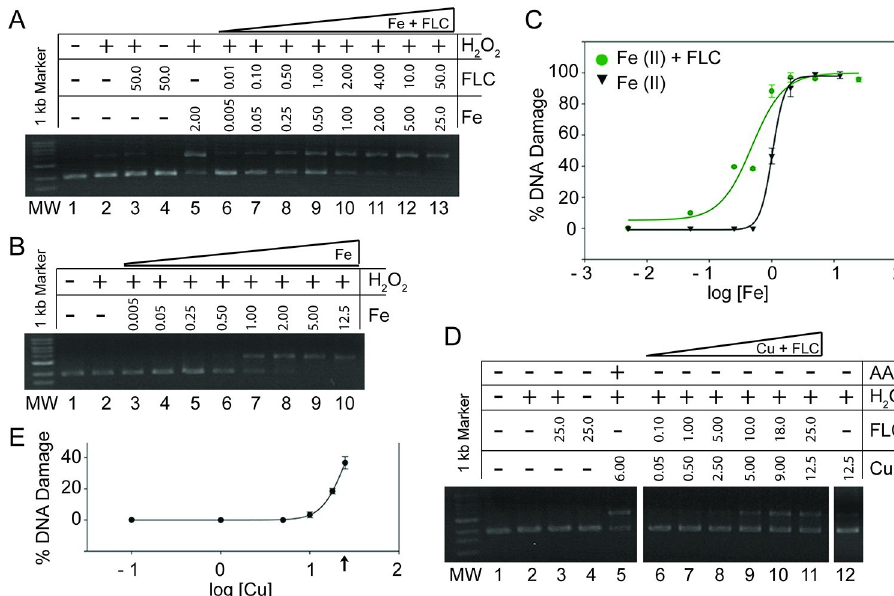
Fig 3. Fluconazole-metal complex causes DNA damage in vitro . A plasmid DNA (p) was incubated with reagents as indicated here and specified in the Materials and Methods. Samples were separated by electrophoresis, gels were stained with ethidium bromide and the amounts of nicked (damaged, upper band) and circular (undamaged, lower band) plasmid (p) were analyzed. In all gels shown (A, B and D), the MW: 1 kb molecular weight marker; lane 1: plasmid DNA (p); lane 2: p + H 2 O 2 . A) Fe II -mediated DNA damage stimulated by FLC. lane 3: p + FLC (50 μ M) + H 2 O 2 ; lane 4: p + FLC (50 μ M); lane 5: p + FeSO 4 (2 μ M) + H 2 O 2 ; lanes 6–13: p + H 2 O 2 + increasing concentrations ( μ M) of FLC and FeSO 4 , as indicated. B) Fe II -mediated DNA damage. lane 3–10: p + H 2 O 2 + increasing concentrations ( μ M) of FeSO 4, as indicated . C) Dose-response curves of iron-mediated DNA damage with and without addition of FLC, based on experiments described in A and B. D) Cu II -mediated DNA damage stimulated by FLC. lane 3: p + FLC (25 μ M) + H 2 O 2 , lane 4: p + FLC (25 μ M); lane 5: p + CuSO 4 (6 μ M) + AA (7.5 μ M) + H 2 O 2 ; lanes 6–11: p + H 2 O 2 + increasing concentrations ( μ M) of FLC and CuSO 4 , as indicated; lane 12: p + CuSO 4 (12.5 μ M) + H 2 O 2 E) Dose-response curve of copper-FLC-mediated DNA damage. An arrow indicates the highest concentration of CuSO 4 at which there was no DNA damage detected when FLC was not